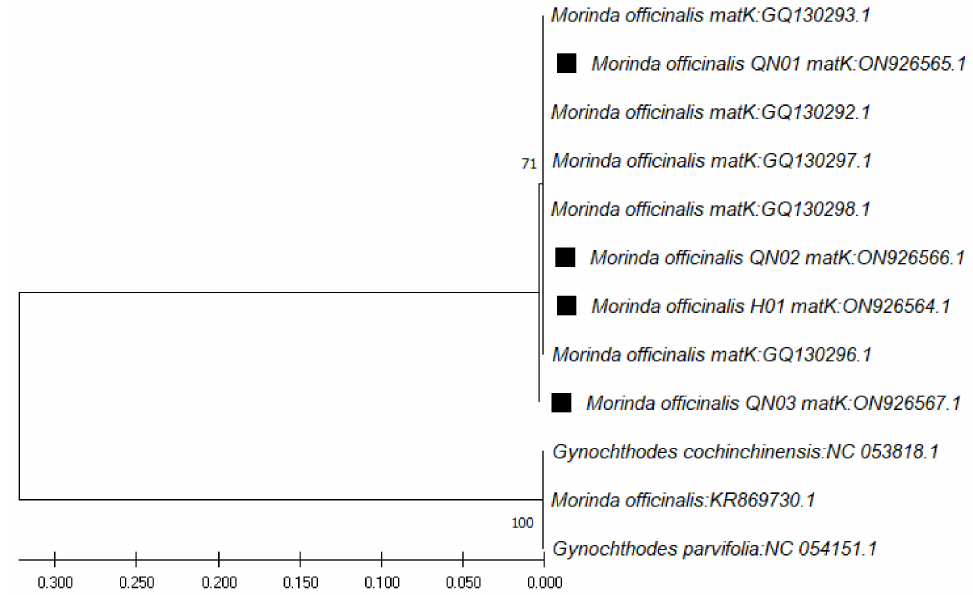
Figure 4. Phylogenetic tree by maximum likelihood of similarity between M. officinalis and the closest species as per matK region sequences. The samples of our study are marked by black squares next to their